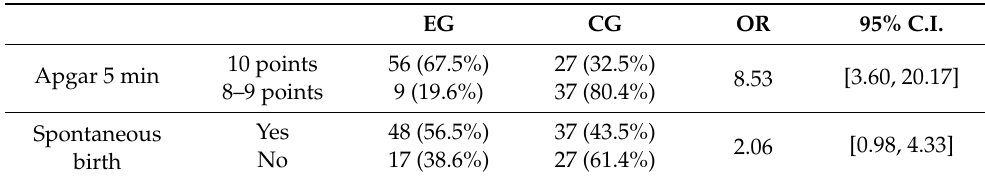
Table 2. Neonatal outcomes by